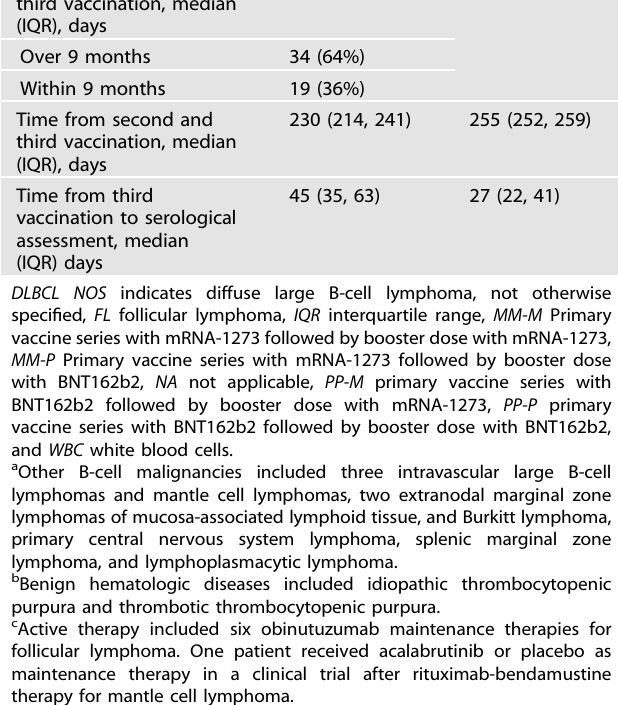
responses (Table S1). Conversely, the presence of humoral response before the third vaccination was associated with higher titers of anti-S1 antibodies, comparable with those of healthy controls (Fig. 1B, Table S1). In addition, a shorter interval between the last administration of anti-CD20 antibodies and the third vaccination was not associated with the acquisition of T-cell responses (Table S2). Details of adverse events (Fig. S1) are available in the supplementary material. Humoral responses are critical for blocking the acquisition of viral infection [9]. In this study, the seropositivity rate before the third vaccination was only 15%, and it improved to 42% after the third vaccination, which is still unsatisfactory but encoura- ging. In some previous studies, the third vaccination was performed within six months after two doses, and their seroconversion rate tended to be lower, probably due to incomplete B-cell recovery [5, 6]. In our study, we expected that a longer interval (>7 months) would positively affect humoral response by allowing B-cell recovery, resulting in a slightly better seroconversion rate. In addition, it should be noted that the anti-S1 antibody titers in patients were substantially lower than those in the healthy volunteers. Anti-S1 IgG titers have been reported to be associated with neutralization activity against SARS-CoV-2, and an observa- tional study has indicated that neutralization activity is absent if anti-S1 antibody levels are low [10]. Among patients with a detectable but weak humoral response after administering two doses of an mRNA COVID-19 vaccine, an increase in antibody levels after administering the third dose has been observed [11]. Our study con fi rmed this fi nding; patients with a detectable